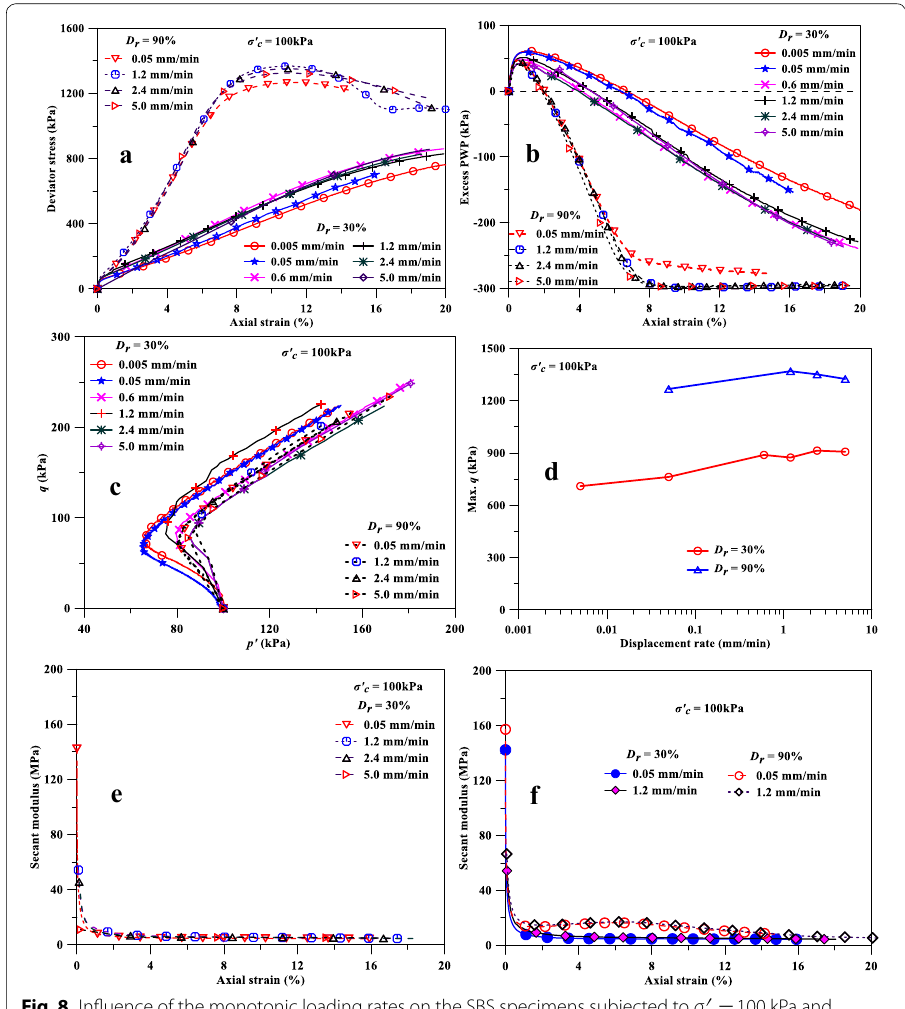
Fig. 8 Influence of the monotonic loading rates on the SBS specimens subjected to σ ′ c prepared at various relative densities a stress–strain response, b excess PWP, c stress path, d maximum deviator stress, e secant modulus for varying loading rates, f comparative analysis of secant modulus for varying loading rates and relative